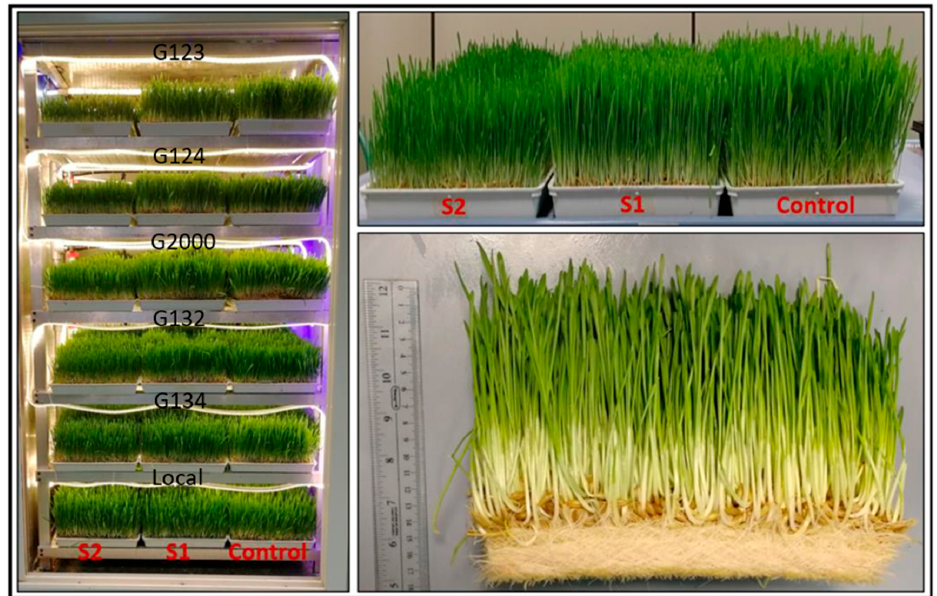
Figure 1. The six barley genotypes after germination in 70 × 30 × 5 cm trays: grown in growth chambers for 8 days, irrigated with 0 mM (control), 50 mM (S1), and 100 mM (S2) NaCl.